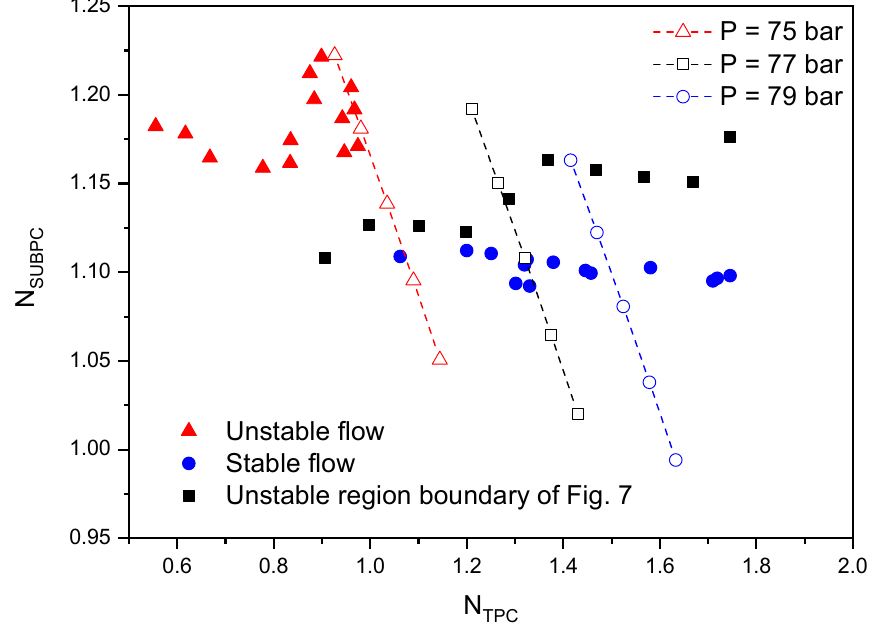
Figure 12. Stability map of supercritical CO 2 .